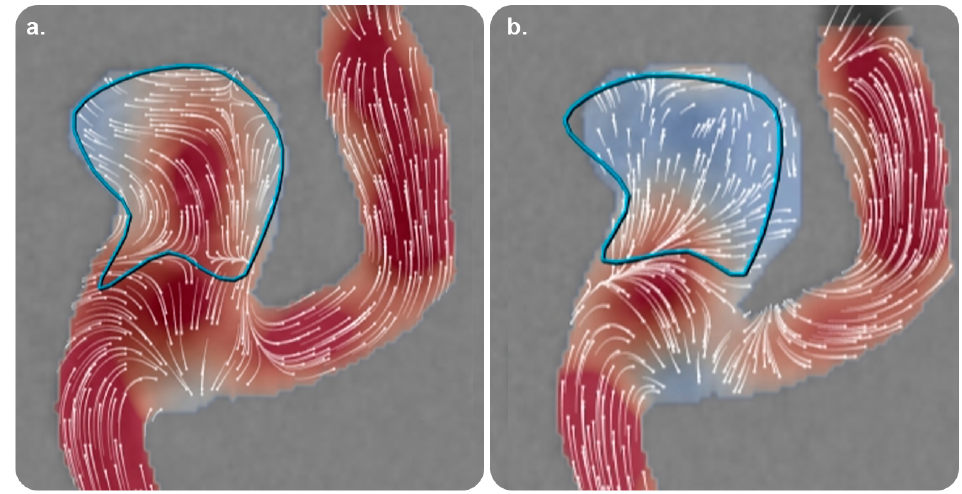
Figure 8. AneurysmFlow software and its role in monitoring therapy. Volume reconstruction images utilizing high-frequency digital subtraction angiography of two different Medina ® Embolization Device configurations (a and b) after implantation in the same aneurysm model. ( a ) Incomplete neck coverage corresponding to moderate flow velocity reduction (41%). ( b ) A different configuration showing better coverage of the neck corresponding to a higher degree of intra-aneurysmal flow velocity reduction (73%). Reprinted from “Intra-aneurysmal flow disruption after implantation of the Medina ® embolization device depends on aneurysm neck coverage” by Frölich et al. [47] with permission from the corresponding author and the publisher (PLOS ONE; Copyright 2018 [with an open access